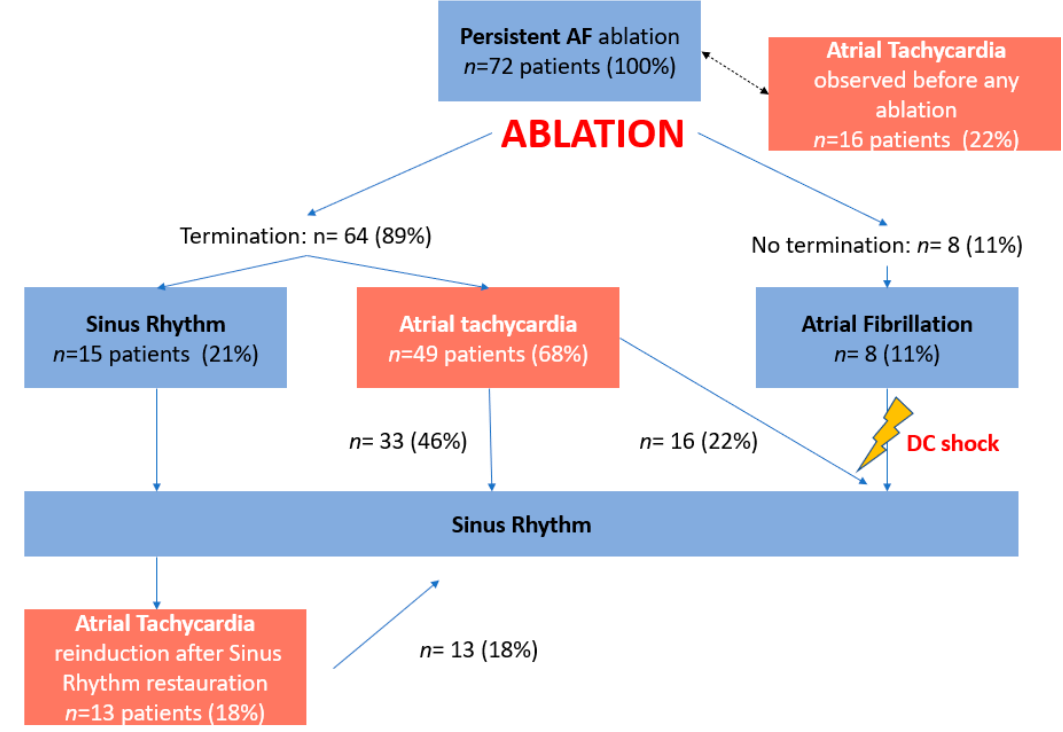
Figure 1. Study flow chart. AF, atrial fibrillation; AT, atrial tachycardia; SR, sinus rhythm. When sinus rhythm was restored by ablation, reinduction (isoproterenol and/or